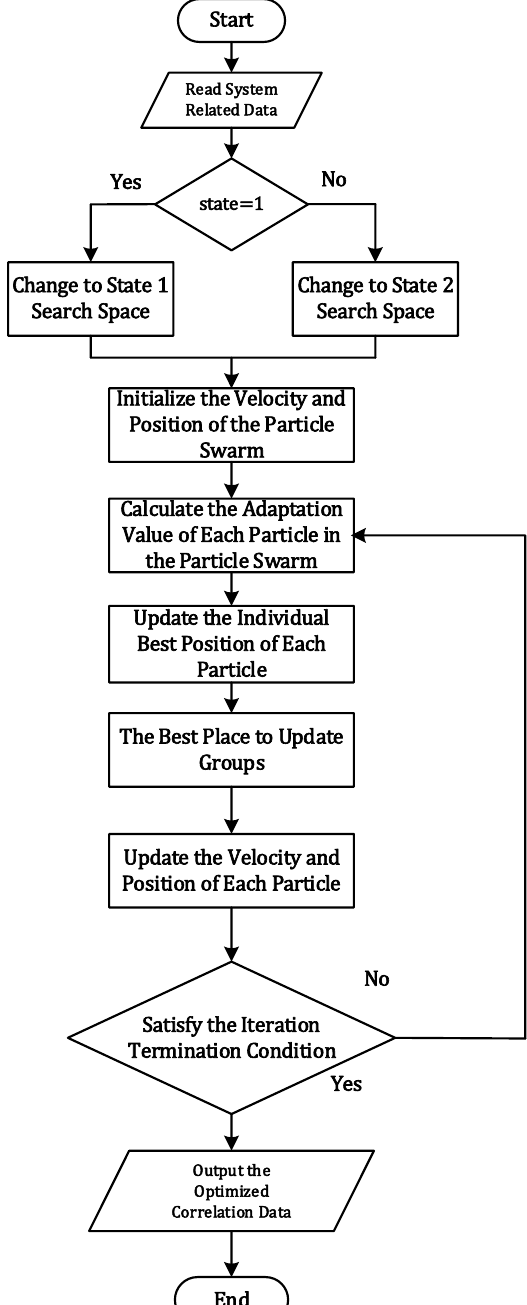
Figure 13. Flowchart of the global rules of PSO.